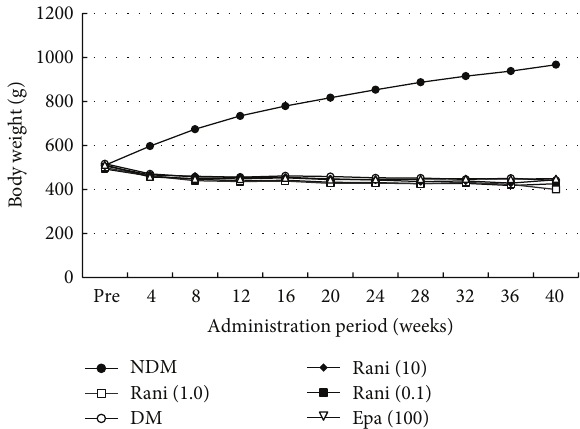
Figure 1: Body weight during the experiment. The SD rats are heavier than the SDT rats with or without treatment. NDM: non-diabetes mellitus; DM: diabetes mellitus; rani: ranirestat; epa: epalrestat.